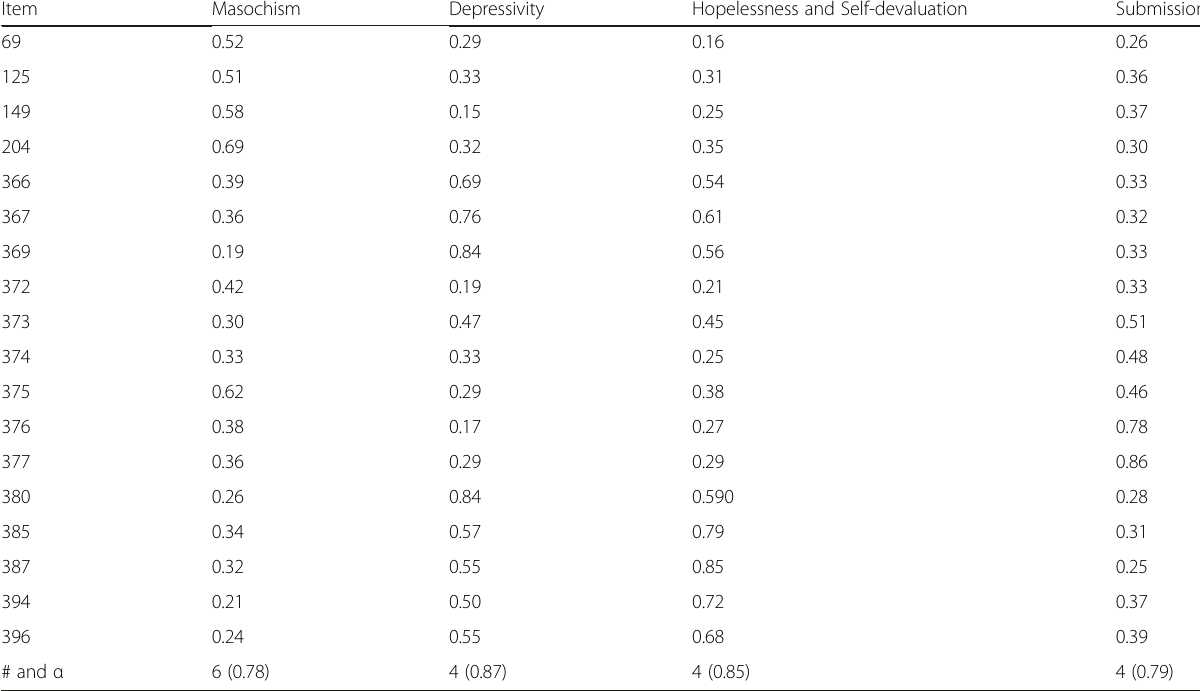
Table 1 Exploratory factorial analysis and internal consistency indexes Item